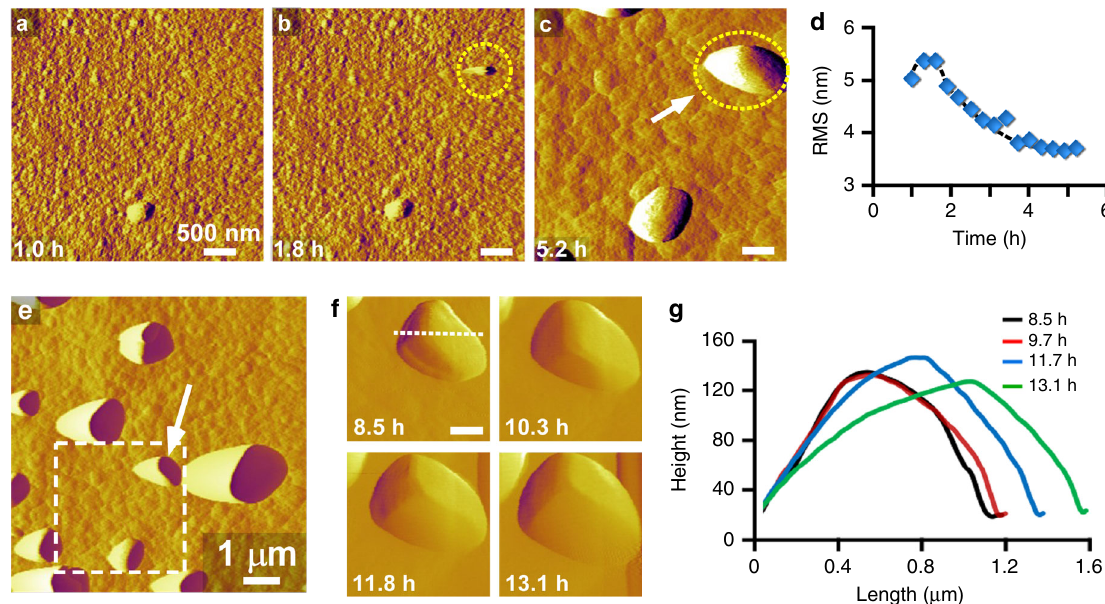
Fig. 3 Evidence of (nearly) oriented attachment. a – c Time-resolved in situ AFM amplitude mode images showing the deposition of a particle from solution to the crystal surface (dashed circle). Measurements were performed in growth solution S2 heated at 45 °C. d Temporal change in the root mean square (RMS) roughness of a 1 × 1- μ m 2 area during continuous imaging. e Enlarged scan area that encompasses a region (dashed box) that was continuously imaged for 6.3 h. f Snapshots from Supplementary Movie 3 showing the growth of a large island (indicated by the arrow in image e). The movie taken in contact mode appears to capture island growth by classical molecule-by-molecule addition. The immediate appearance of facets on the nanoparticle suggests that these features are crystalline. g Graph showing the variation in height and length of a single deposit (indicated by the arrow in image c). Pro fi les are taken along the dashed line in image f as a function of time ( t = 8.5 – 13.1 h). Scale bars are equal to 500 nm unless otherwise